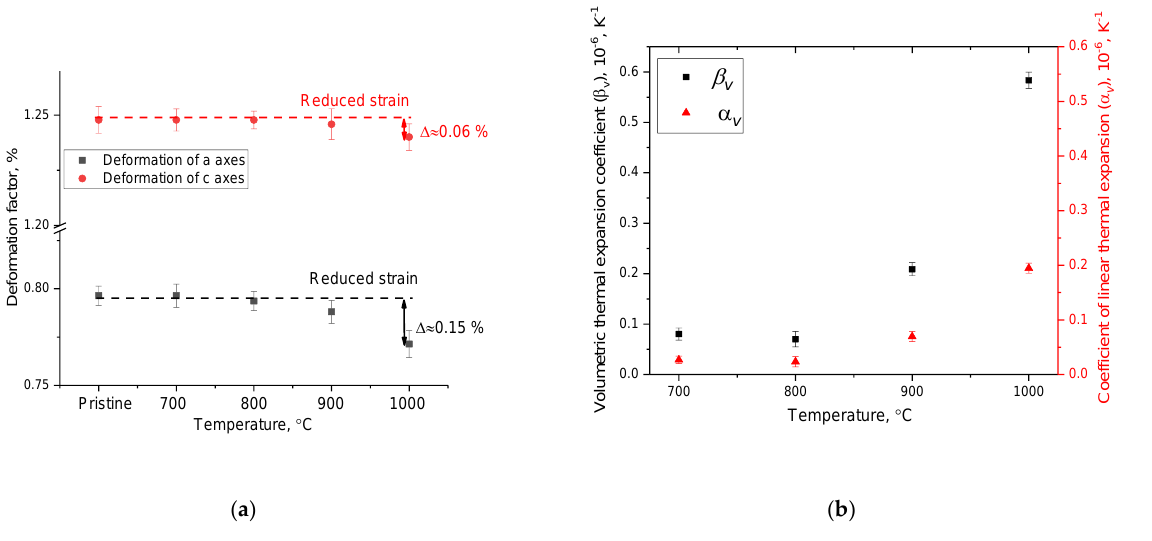
Figure 13. ( a ) Change in the parameters of the deformation factor depending on the annealing temperature of the samples; ( b ) change in the values of volumetric and linear coefficients of ther- mal expansion.